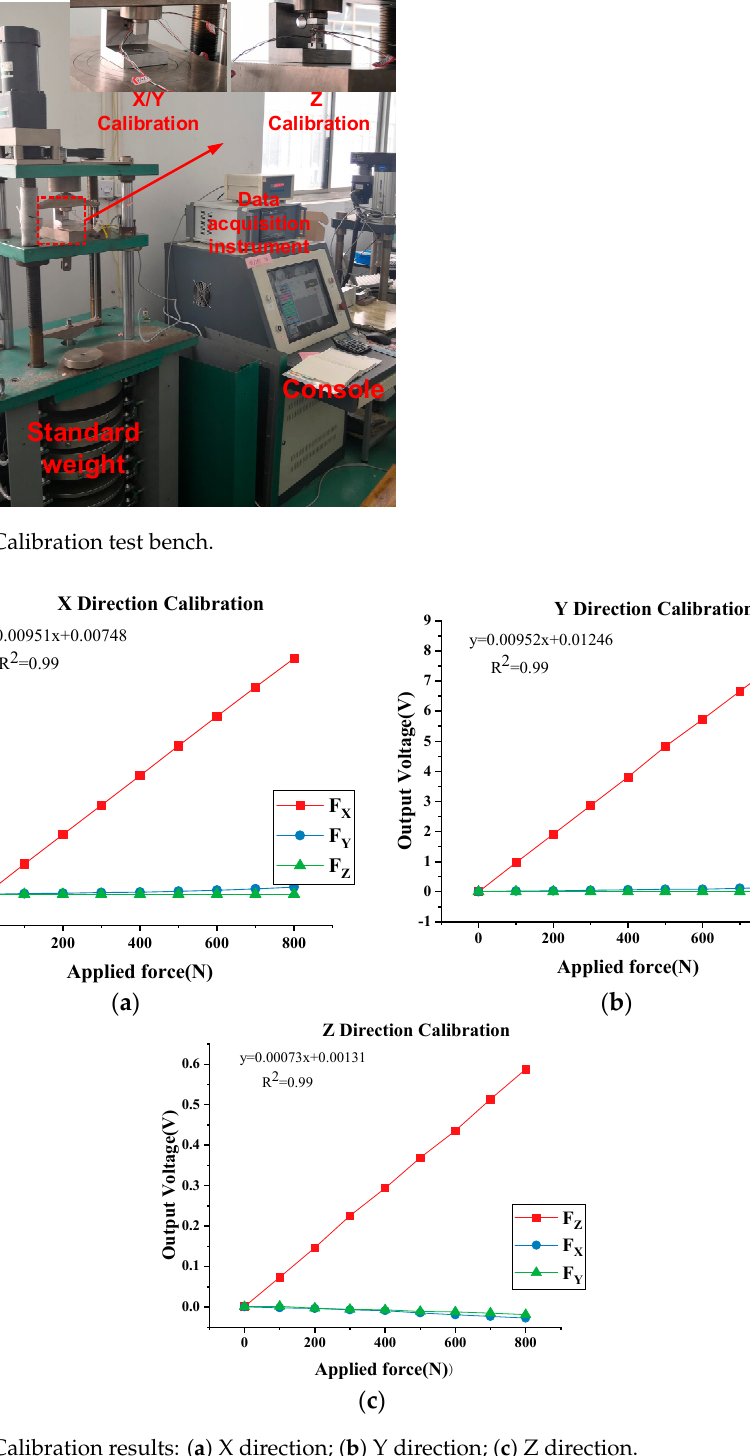
( c ) Figure 7. Calibration results: ( a ) X direction; ( b ) Y direction; ( c ) Z direction. The X direction and Y direction were mutually perpendicular and symmetric, and the loading curves and output voltages were similar. The measurements were approxi- mately linear over the tested range. The performance of the sensor was determined through multiple loading and unloading tests from 0 to 800 N in the three directions (Ta- ble 1). From the third column in Table 1, it can be seen that the maximum error value of